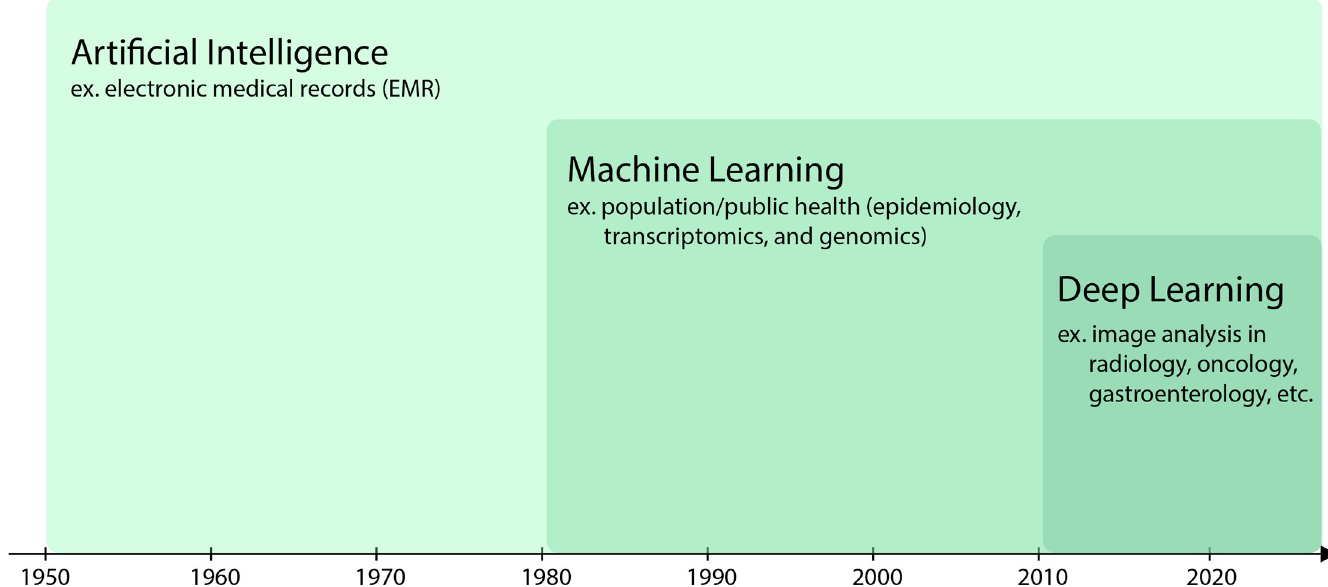
Fig 1. Understand what Artificial Intelligence is. Data analysis techniques have become more advanced over time. The elaboration of artificial intelligence techniques influenced machine learning. Similarly, the sophistication of machine learning prompted evolution into deep learning as shown in this figure adapted from Le Berre and colleagues [13]. Each approach shows an example of its application in the biomedical